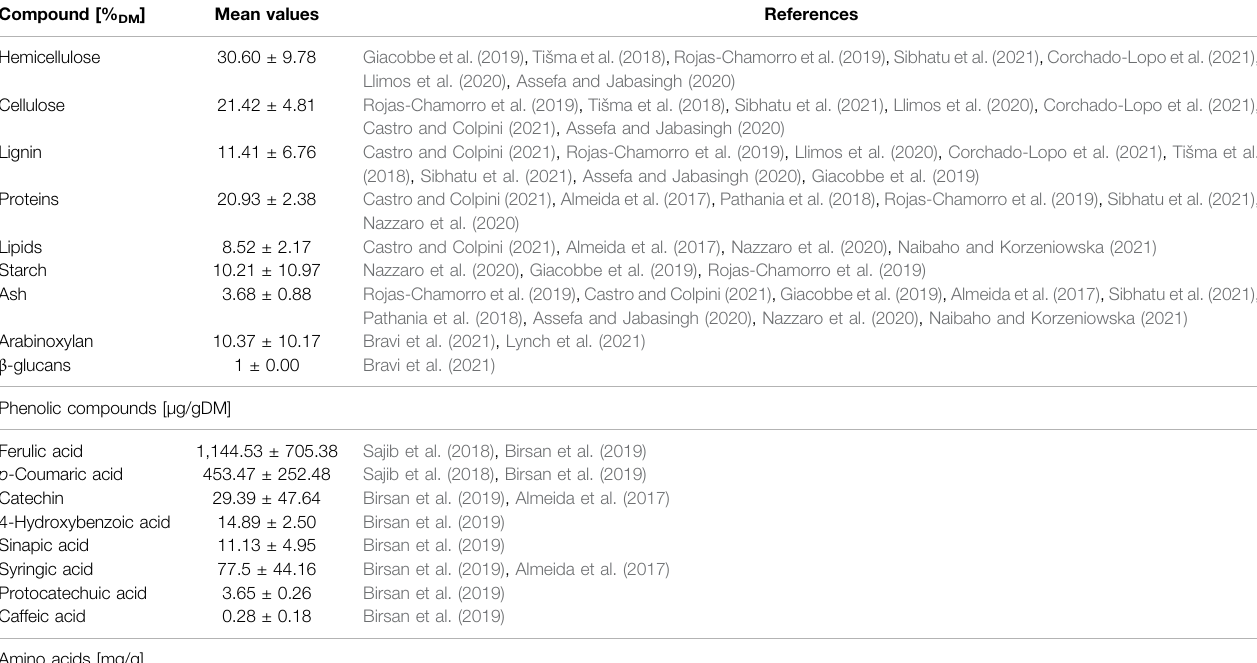
TABLE2| EstimatedmeanvaluesofBSGprimarycomponentscalculatedfromtheliteraturedatastatedinthetable.Thevaluesareexpressedasapercentageofdrymatter (% DM ), or with an appropriate unit of measurement, with indicated standard